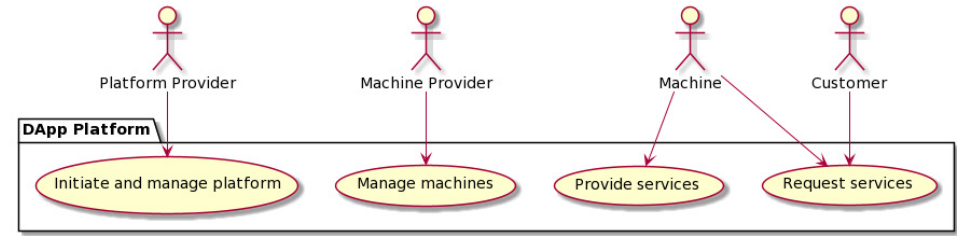
Table 1. System participants and their foreseen smart contract roles.